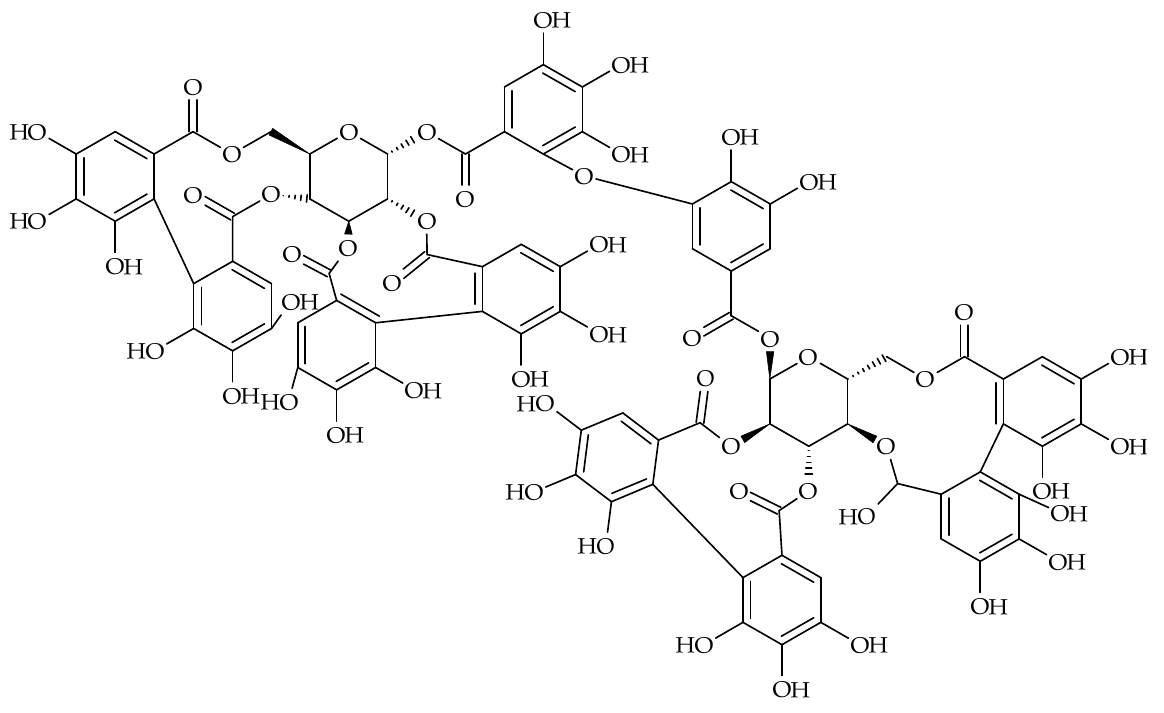
Figure 3. Chemical structure of agrimoniin.